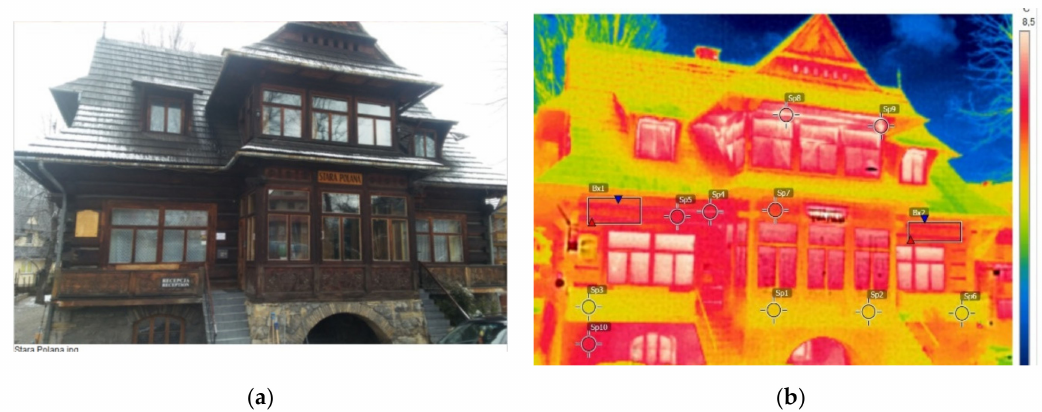
Figure 6. ( a ) Front facade. ( b ) General thermovision analysis of the Stara Polana building using a FLIR camera.